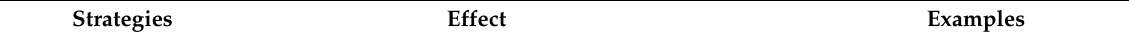
Table 1. State-of-the-art in treatments against pneumonia caused by Gram-positive